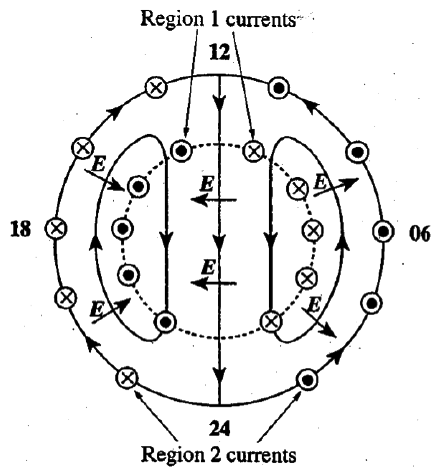
Figure 9. Schematic of the ionospheric flow streamlines (arrowed curves) and associated electric field pattern. Arrows facing inward and outward show the locations of field-aligned currents, the inner and outer rings being the region 1 and region 2 currents, respec- tively. The dashed line marks the open–closed field line boundary (Fig. 1 from Cowley,